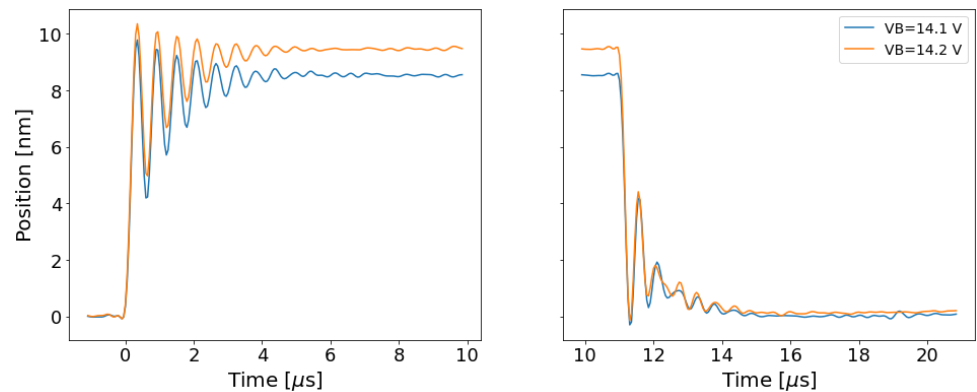
Figure 3. Displacement of the relay during transients that make contact with the surface. V B is higher during these measurements to allow the relay to make contact. The bump in the contacting behavior during the closing transient reflects additional displacement of the gate structure of the relay after the drain and source are in contact, and that displacement may be influenced by squeeze film damping. ( left ) Displacement when the relay is openining. ( right ) Displacement when the relay is closing and making contact.